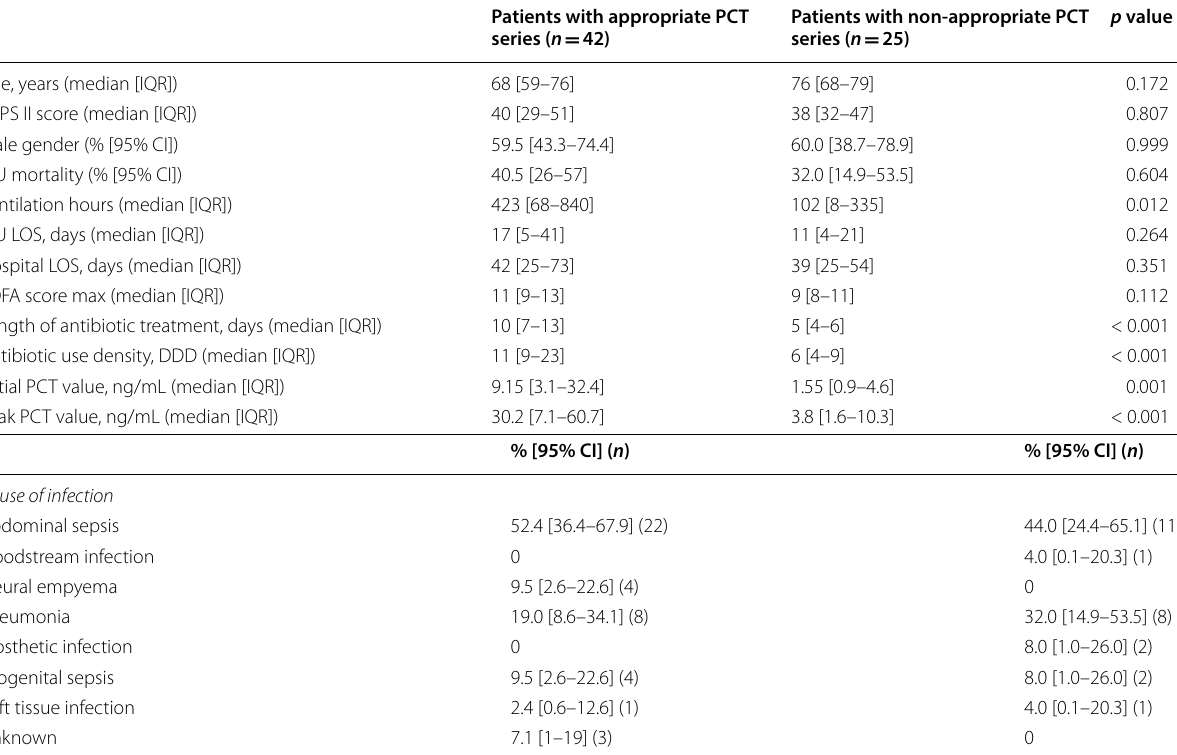
Table 1 Demographics and clinical data of patients with appropriate and non-appropriate procalcitonin (PCT) measurement